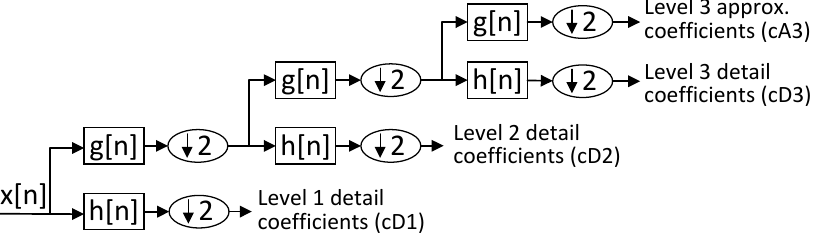
Figure 3. Bank filter for generating the coefficients of the discrete wavelet